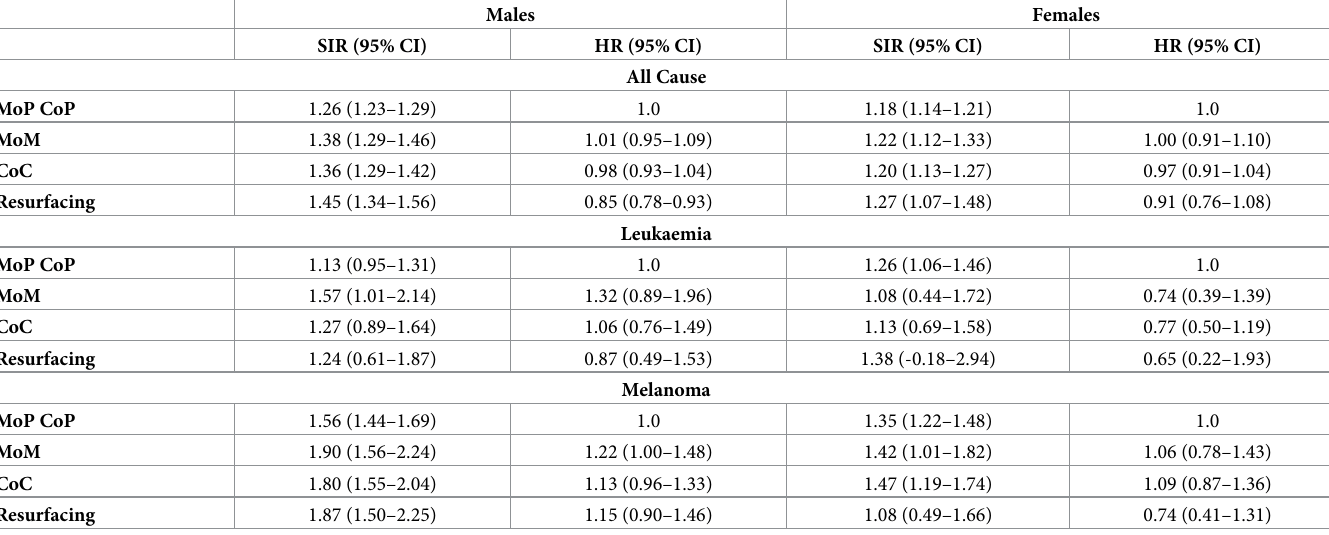
Table 4. Risk of cancer incidence by gender for all-cause and site-specific cancers, by bearing